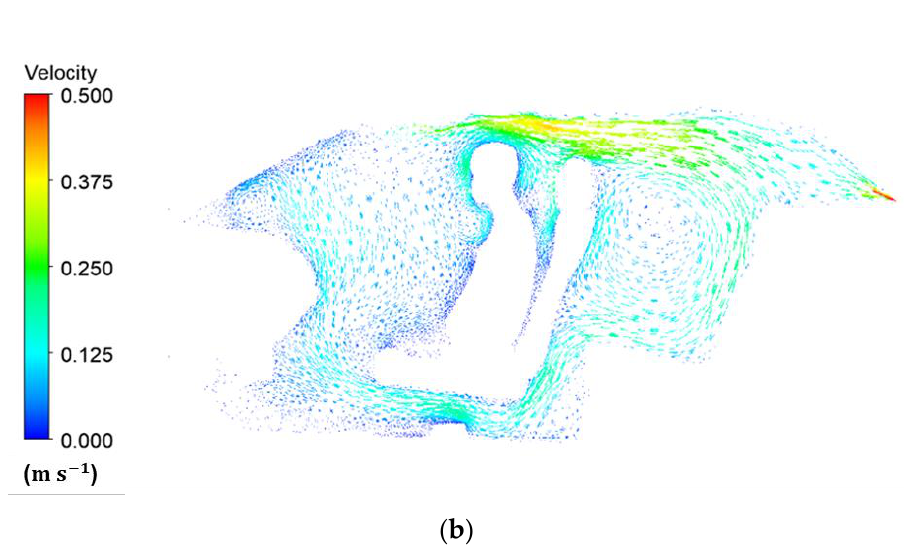
Figure 7. Velocity vectors on a plane passing through the ( a ) driver’s body and ( b ) passenger’s body.